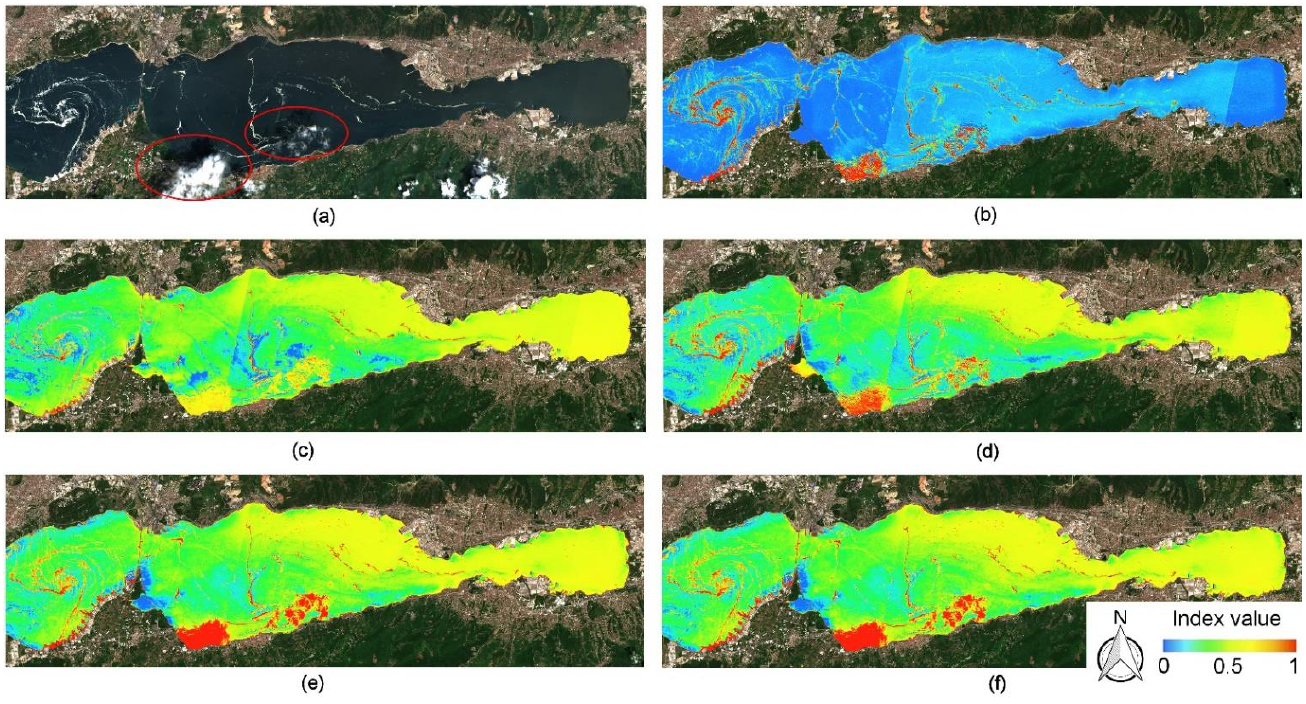
Figure 5. Thematic maps produced for ( a ) cloudy 13 July Sentinel-2 imagery using ( b ) AFAI; ( c ) MI; ( d ) NDTI; ( e ) NDWI; ( f ) NDWI Gao . ( d ) NDTI; ( e ) NDWI; ( f ) NDWI Gao